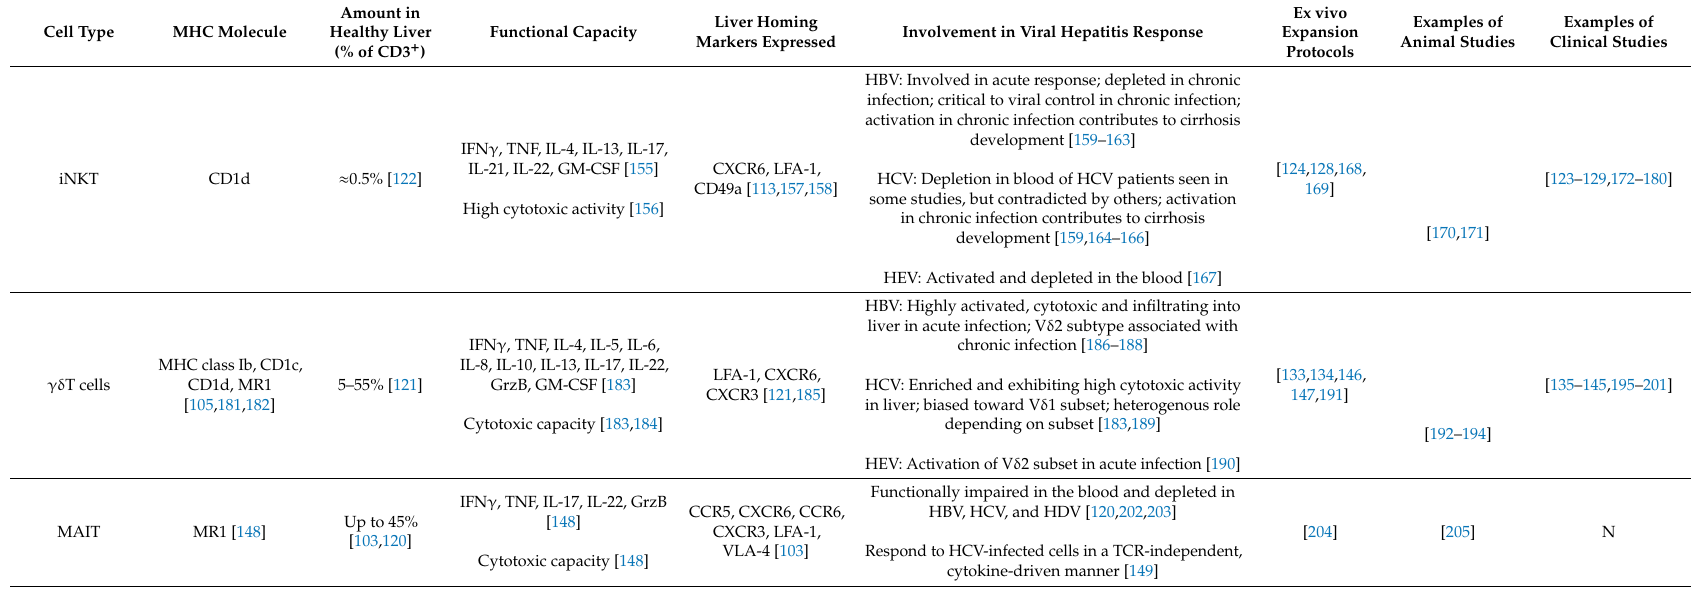
Table 2. Summary of characteristics of unconventional T cell subsets. IFN: interferon, iNKT: invariant natural killer T cells, MHC: major histocompatibility complex, TCR: T cell